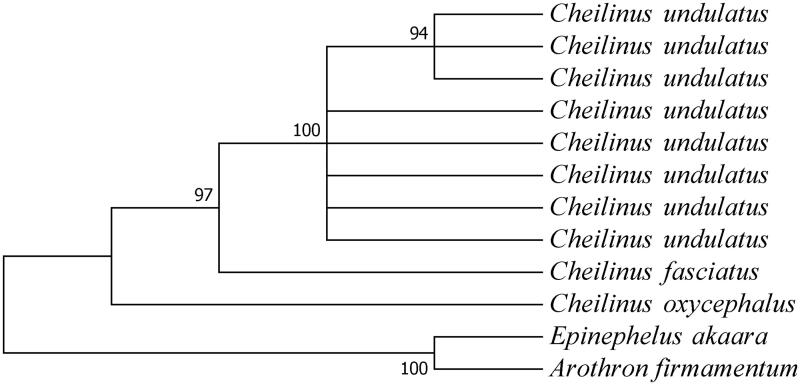
Phylogenetic relationships based on complete mtDNA sequences. Numbers at each node are neighbor-joining bootstrap proportions. The accession numbers in order are AP006742.1 (Arothron firmamentum), KJ700439.1 (Epinephelus akaara), MN399860 (Cheilinus oxycephalus), NC 037707.1 (Cheilinus fasciatus), MH688052.1 (Cheilinus undulates), MH675879.1 (Cheilinus undulates), MH688050.1 (Cheilinus undulates), GU296101.1 (Cheilinus undulates), KM461717.1 (Cheilinus undulates), MH688051.1 (Cheilinus undulates), MH675880.1 (Cheilinus undulates), and MH688049.1 (Cheilinus undulates), respectively.